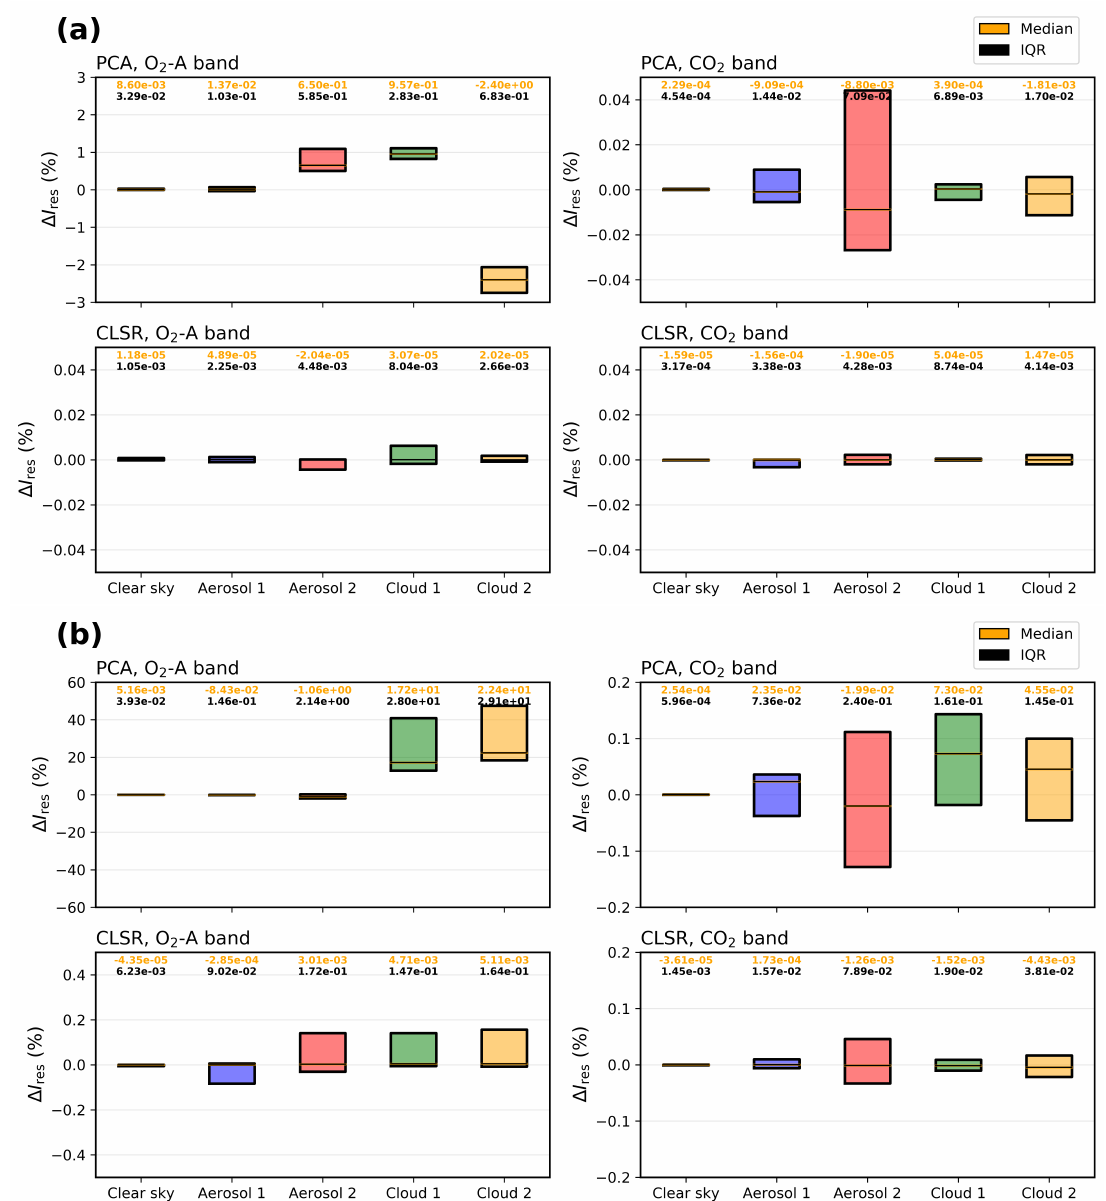
Figure 9. Comparison of the residuals for the methods PCA and CLSR for all the atmospheric scenarios (grey: ‘Clear sky’; blue: ‘Aerosol 1’; red: ‘Aerosol 2’; green: ‘Cloud 1’; yellow: ‘Cloud 2’) and gases (O 2 A- and CO 2 bands), when the low-stream model is ( a ) the two-stream model or ( b ) the single-scattering model. Note the differences in scales for the PCA technique for the O 2 A-band with the rest of cases. The orange values on top of each box indicate the median values and the black values correspond to the IQR